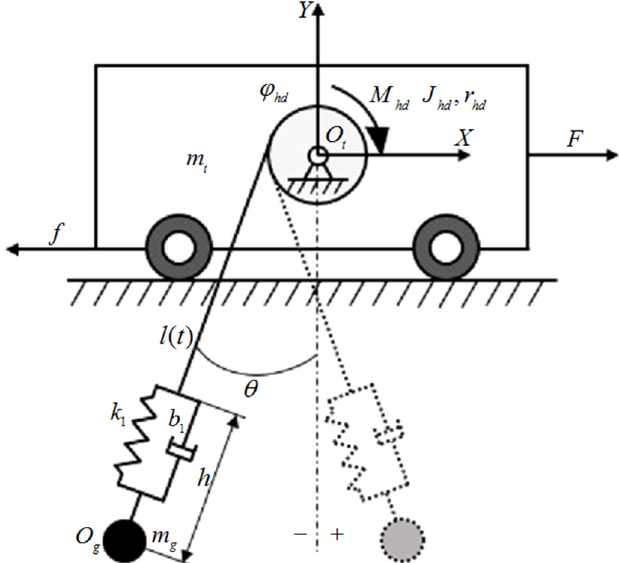
Fig. 2. Dynamic model of trolley-grab system with elastic wire – The lifting drum is simpli fi ed as a fi xed pulley with a